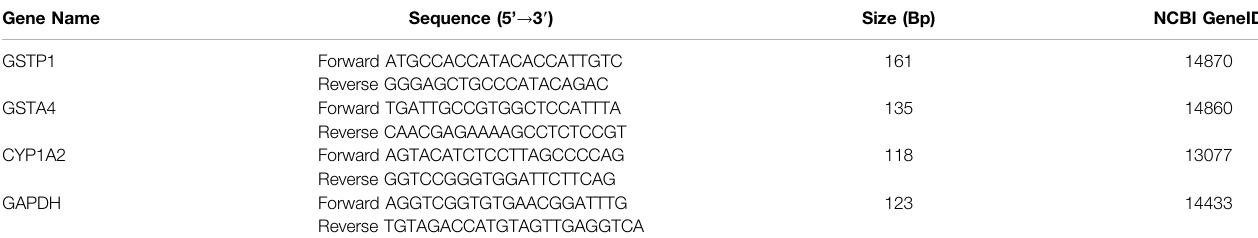
TABLE 1 | Primer sequences for qRT-PCR.